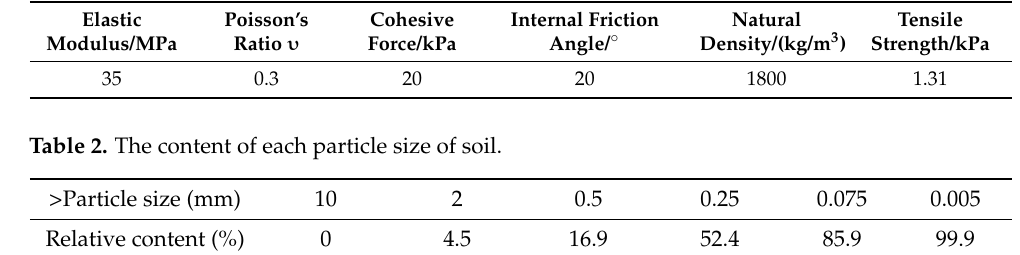
Table 1. The physical and mechanical parameters of soil particles.